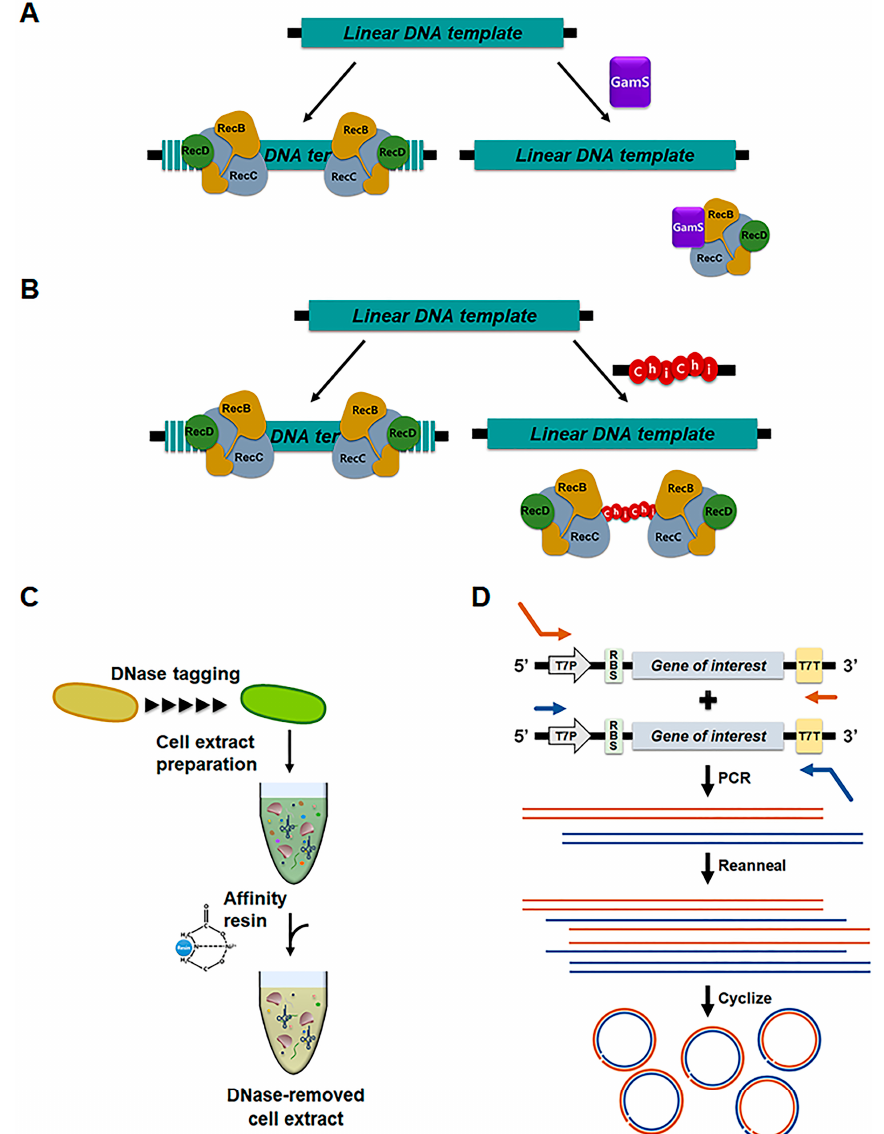
Figure 3. Strategies for improving the stability of linear DNA templates in cell-free protein synthesis systems. ( A ) Stabilization of linear template by use of GamS protein, an inhibitor of